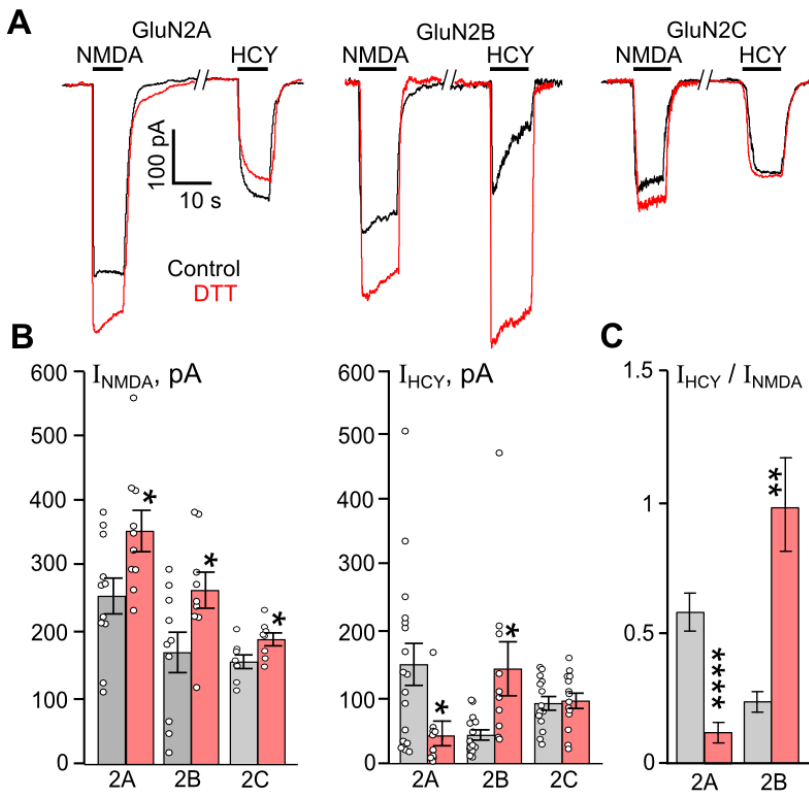
Figure 1. Comparison of DTT effects on currents activated by NMDA and HCY in HEK293 cells expressing recombinant NMDARs. ( A ) Representative current traces recorded at V h = − 70 mV in cells expressing either GluN1 / 2A, GluN1 / 2B, or GluN1 / 2C receptors activated by 100 µ M NMDA and 100 µ M HCY in control (black) and after treatment with 1 mM DTT for 90 s (red). Applications